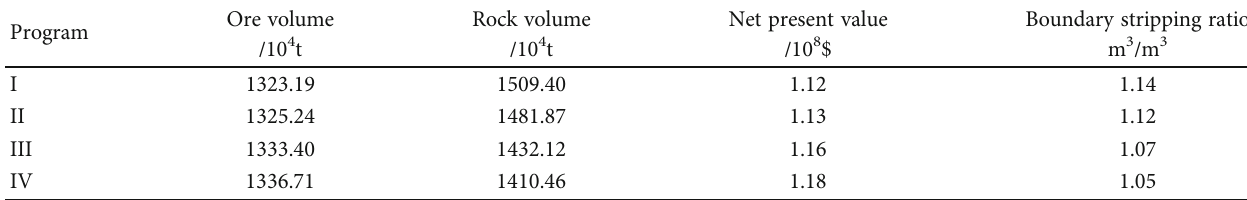
Table 8: Comparison of income parameters of each